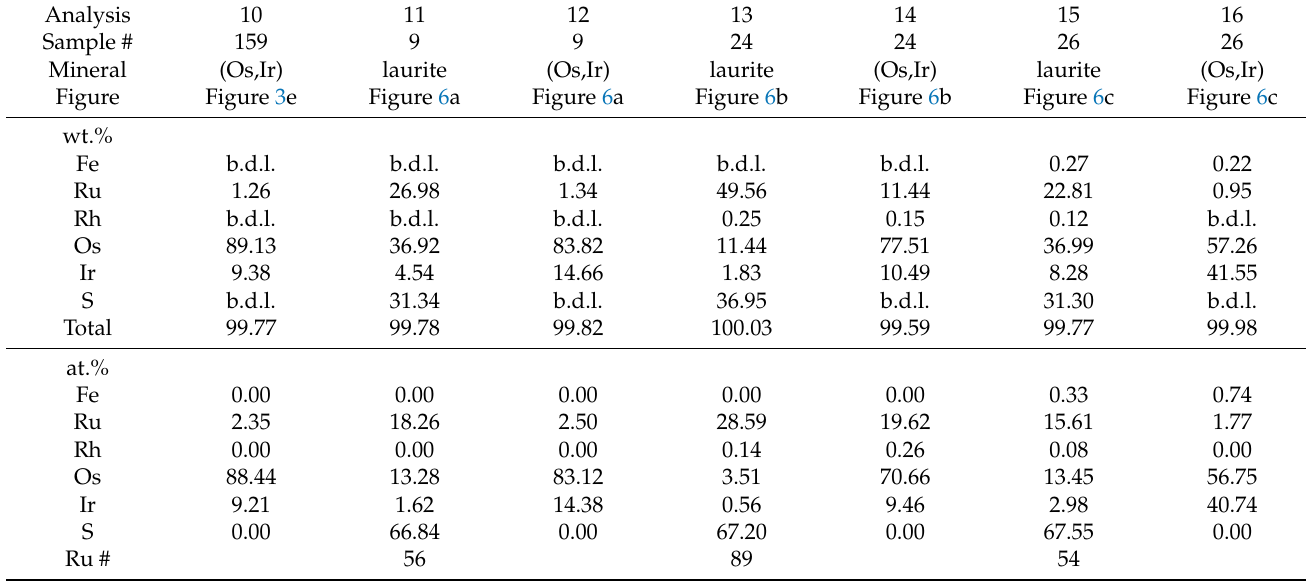
Table 2. Electron microprobe analyses of Ru-Os sulfides of type 2 and coexisting Os-Ir alloys from the Verkh-Neivinsk massif.